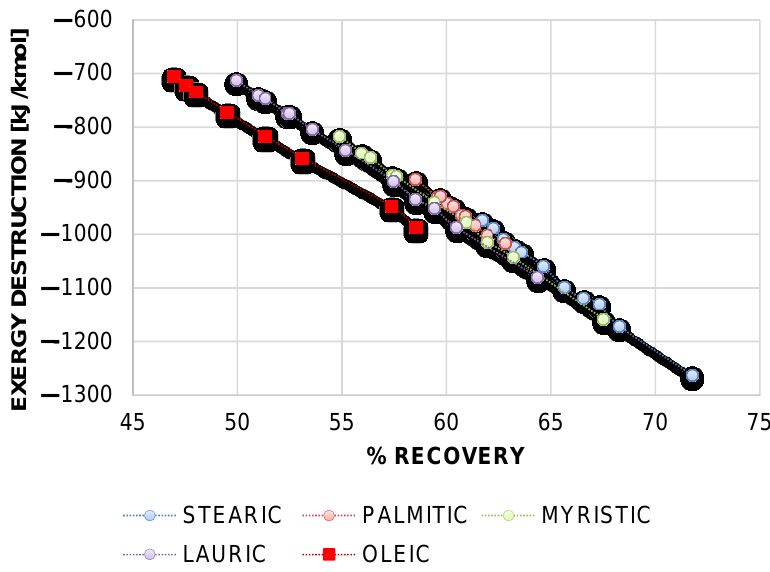
Figure 8. Influence of the recovery on the exergy degraded by the extraction. As it is expected, a higher recovery than a higher exergy degradation is calculated. According to exergy results, no significant differences are obtained from different free fatty acids and oil mixtures, and the use of mixtures can be more advantageous since the purification would be avoided. Mixtures of many free fatty acids are able to provide an extraction as pure oleic acid or even